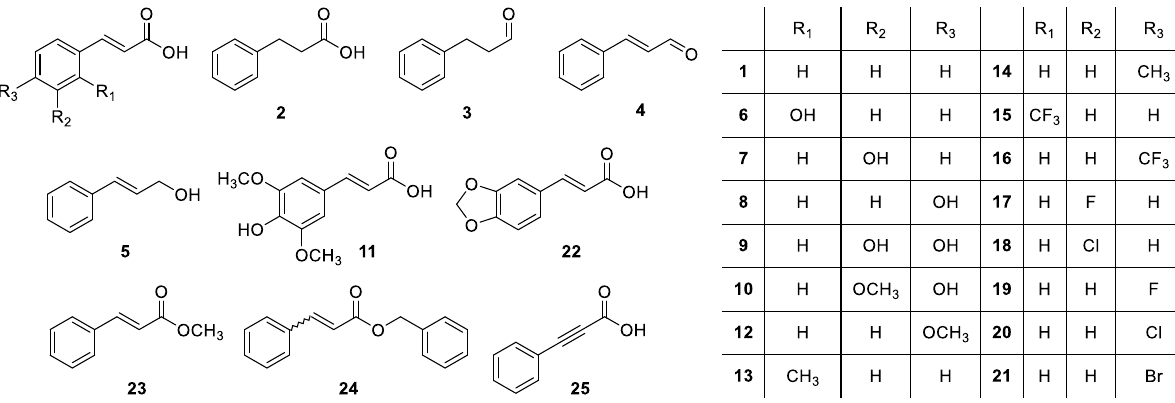
Figure 1. Chemical structures of the compounds studied: trans -cinnamic acid ( 1 ), hydrocinnamic acid ( 2 ), 3-phenylpropionaldehyde ( 3 ), trans -cinnamaldehyde ( 4 ), trans -cinnamyl alcohol ( 5 ), trans - o -coumaric acid ( 6 ), trans - m -coumaric acid ( 7 ), trans - p -coumaric acid ( 8 ), trans -caffeic acid ( 9 ), trans - ferulic acid ( 10 ), trans -sinapic acid ( 11 ), trans -4-methoxycinnamic acid ( 12 ), trans -2-methylcinnamic acid ( 13 ), trans -4-methylcinnamic acid ( 14 ), trans -2-(trifluoromethyl)cinnamic acid ( 15 ), trans -4-(trifluoromethyl)cinnamic acid ( 16 ), trans -3-fluorocinnamic acid ( 17 ), trans -3-chlorocinnamic acid ( 18 ), trans -4-fluorocinnamic acid ( 19 ), trans -4-chlorocinnamic acid ( 20 ), trans -4-bromocinnamic acid ( 21 ), trans -3,4-(methylenedioxy)cinnamic acid ( 22 ), methyl trans -cinnamate ( 23 ), benzylcinnamate ( 24 ), and phenylpropiolic acid ( 25